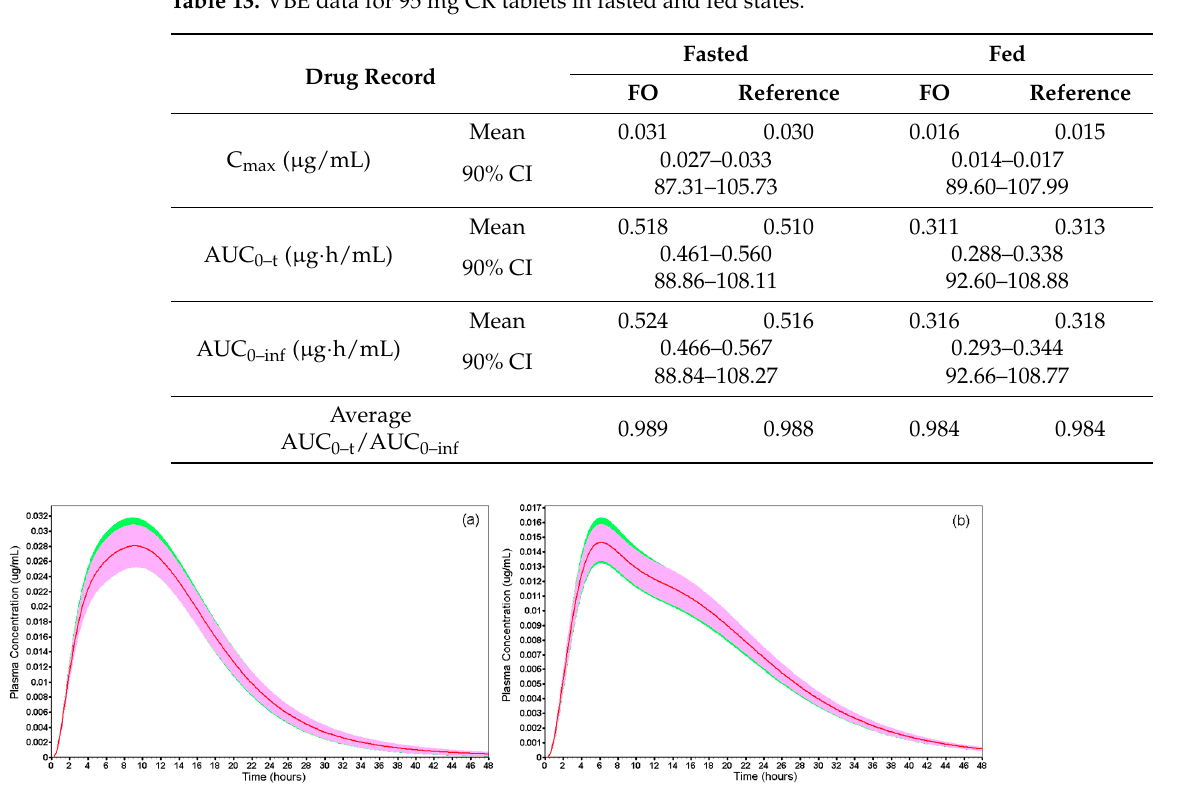
metoprolol succinate ER tablet, in which the simulation used the reference’s experimental dissolution profile that was obtained as described previously.